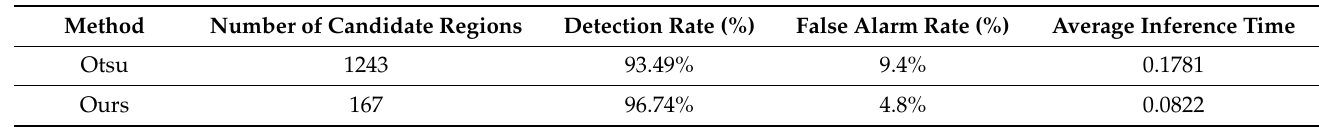
Table 3. Effects of different threshold segmentation methods on detection rate, false alarm rate, and average inference time.